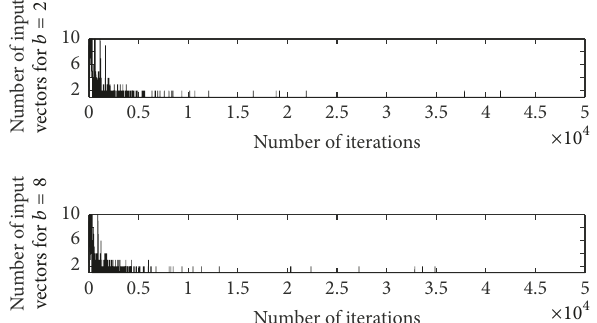
Figure17:NumbersofinputvectorsusedintheproposedFXECAP- L algorithm when 𝐿 = 10 and 𝑏 = 2 or 𝑏 = 8 .